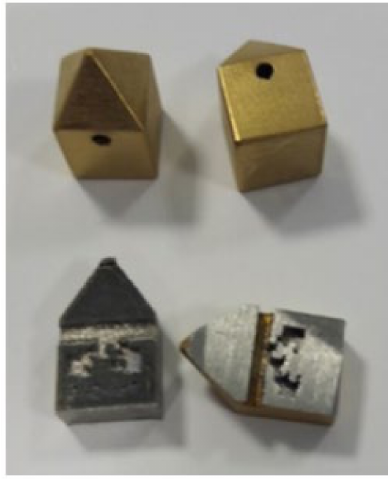
Figure 2. TiN-coated specimens—Set